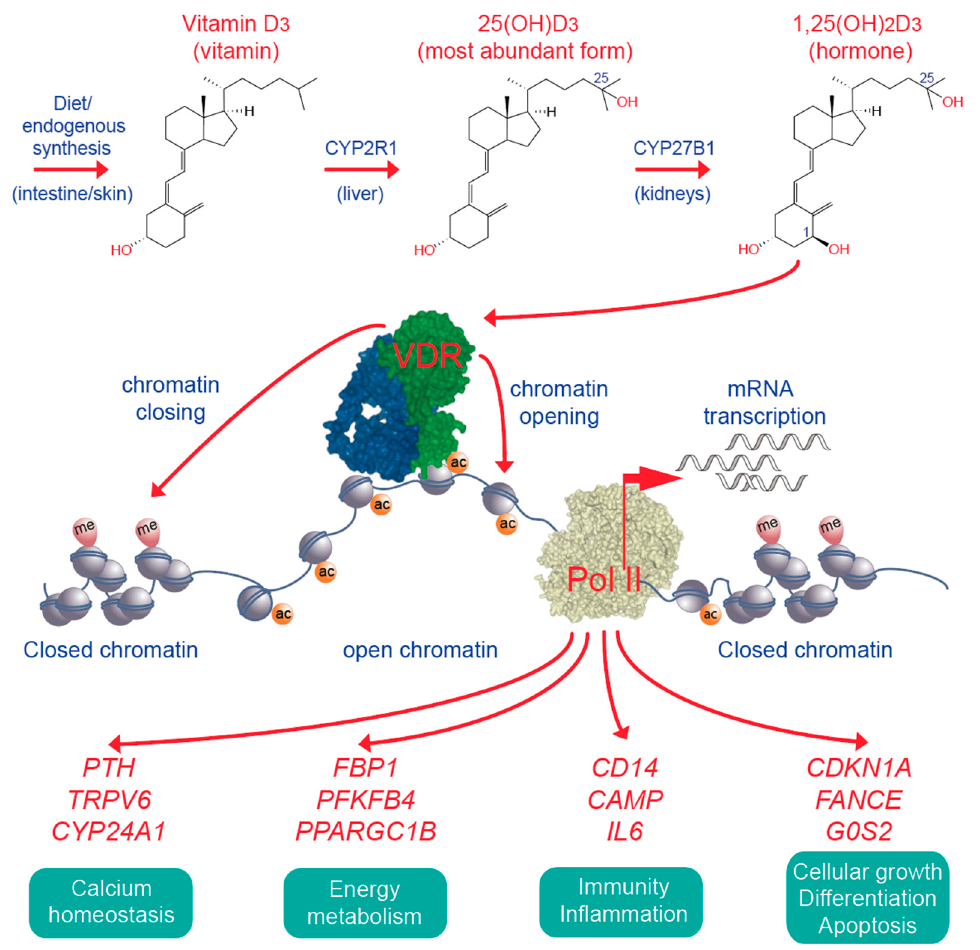
Figure 4. Key elements of vitamin D signaling. Vitamin D 3 is obtained from diet or supplementation or synthesized endogenously in UV-B exposed skin. In the liver and the kidneys vitamin D 3 is converted to 25(OH)D 3 and 1,25(OH) 2 D 3 (top). The latter activates the VDR (green), which bind together with its preferred co-receptor retinoid X receptor (blue) to accessible genomic binding sites (center). In the chromatin environment of its binding sites activated VDR a ff ects chromatin opening and closing (see Figure 3 as illustrative example), which results in the up- and down-regulation of vitamin D target genes. Representative vitamin D target genes are sorted into four di ff erent physiological functions (bottom). Pol II, RNA polymerase II; CYP, cytochrome P450.